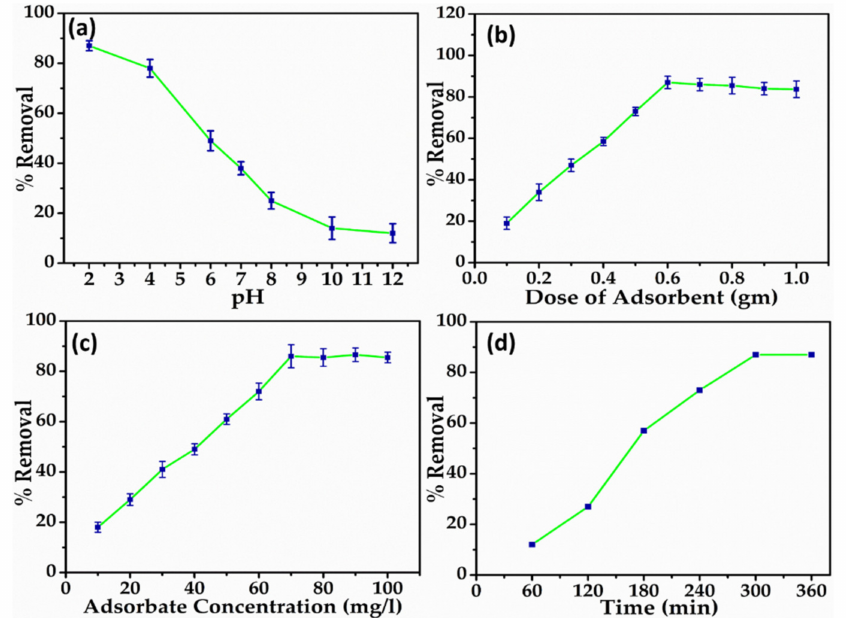
Figure 4. The percentage removal of Cr 6+ at different pH ( a ) and at a different adsorbent concentration ( b ). Cr 6+ ions removal rate at different adsorbent concentrations ( c ) and effect of contact time on percentage removal of Cr 6+ ions ( d